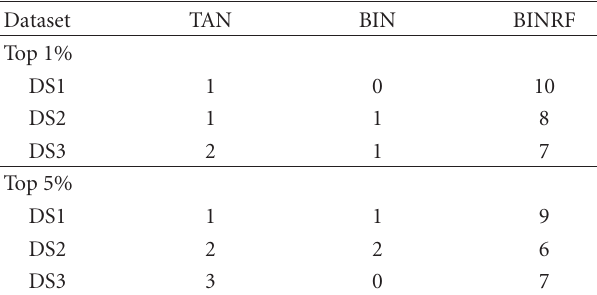
Table 7: Rankings of weighting functions based on Kendall W test results: DS1–DS3 Top 1% and 5%. Dataset